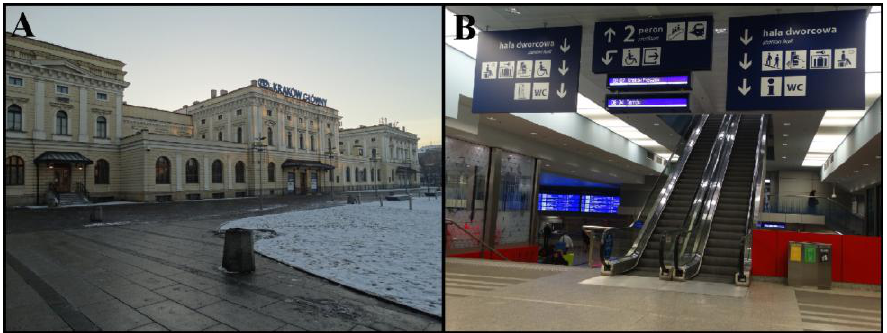
Fig. 8. The old, decommissioned railway station in Cracow (A) and the new underground station